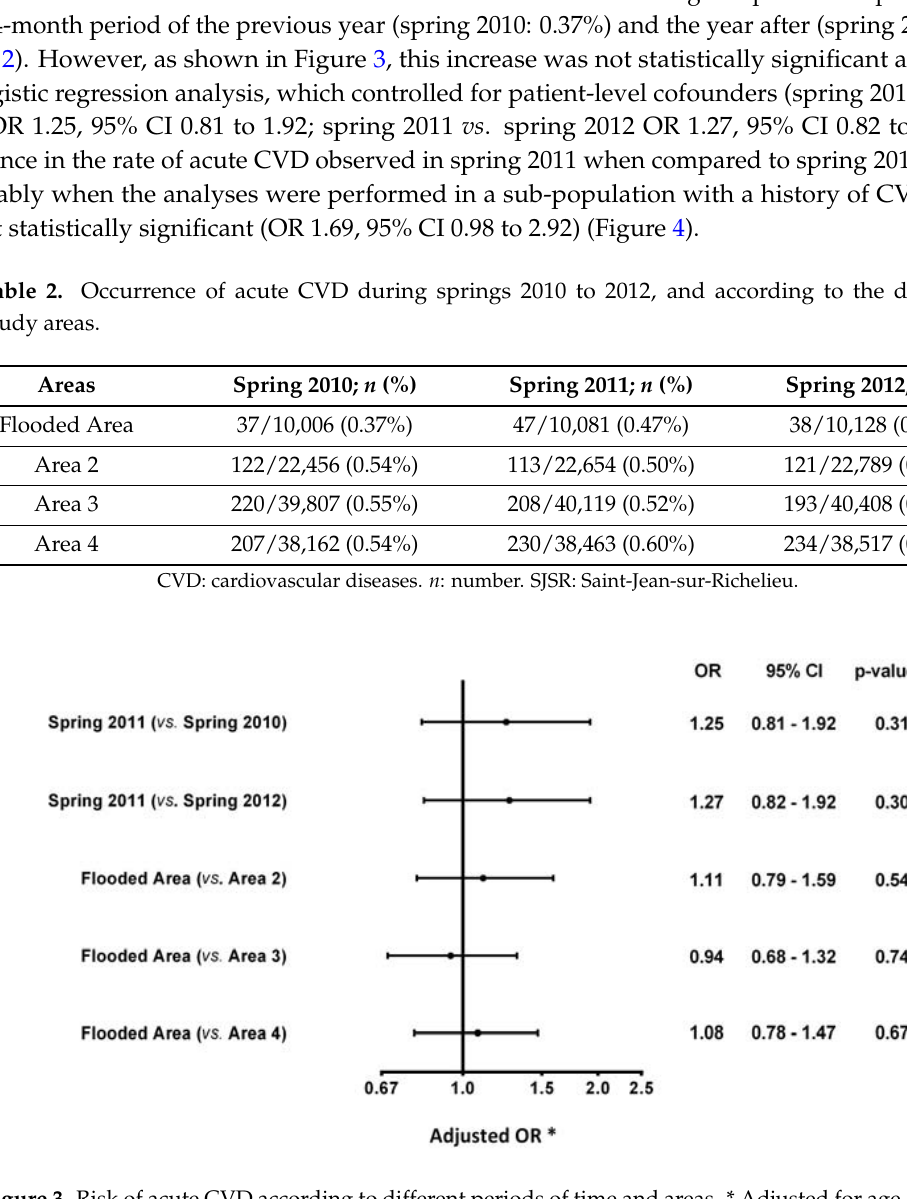
Figure 3. Risk of acute CVD according to different periods of time and areas. * Adjusted for age, gender, Charlson comorbidity index, history of CVD, diabetes, hypertension, and mental health disorders. CI: confidence intervals, OR: odds ratio.